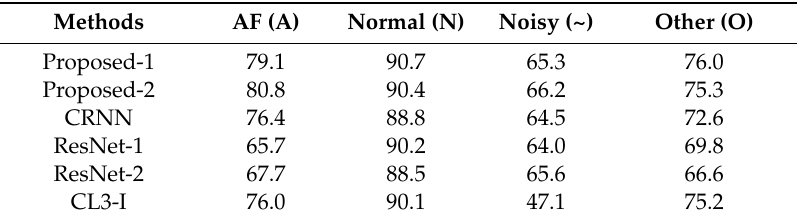
Table 8. Comparison of prediction accuracy of various methods.